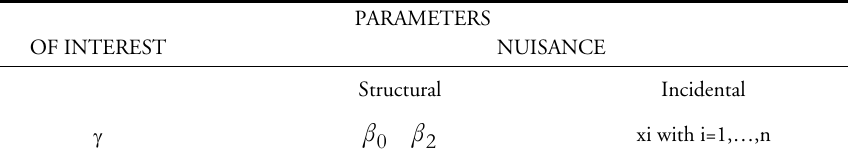
Classification of the parameters